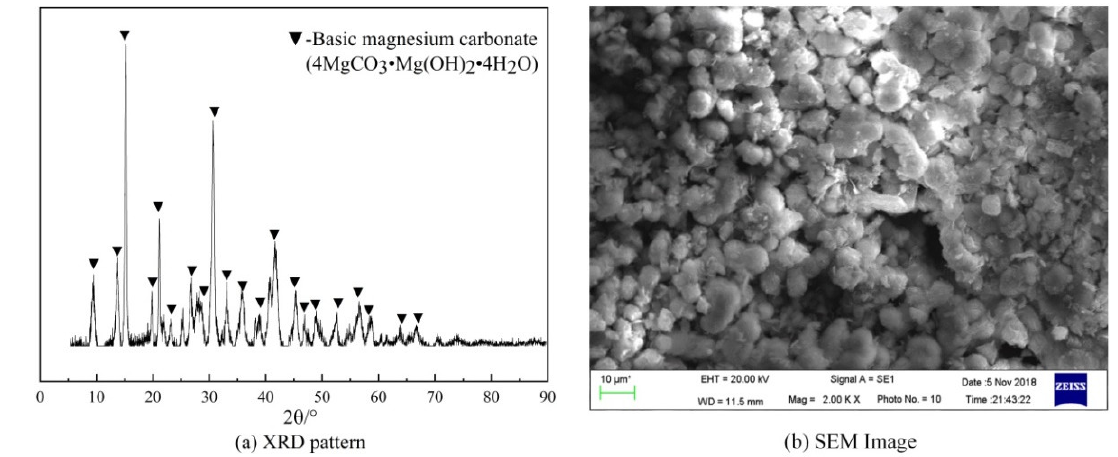
Figure 10. Analysis of magnesium precipitation product ( a ) XRD pattern; ( b ) SEM image.